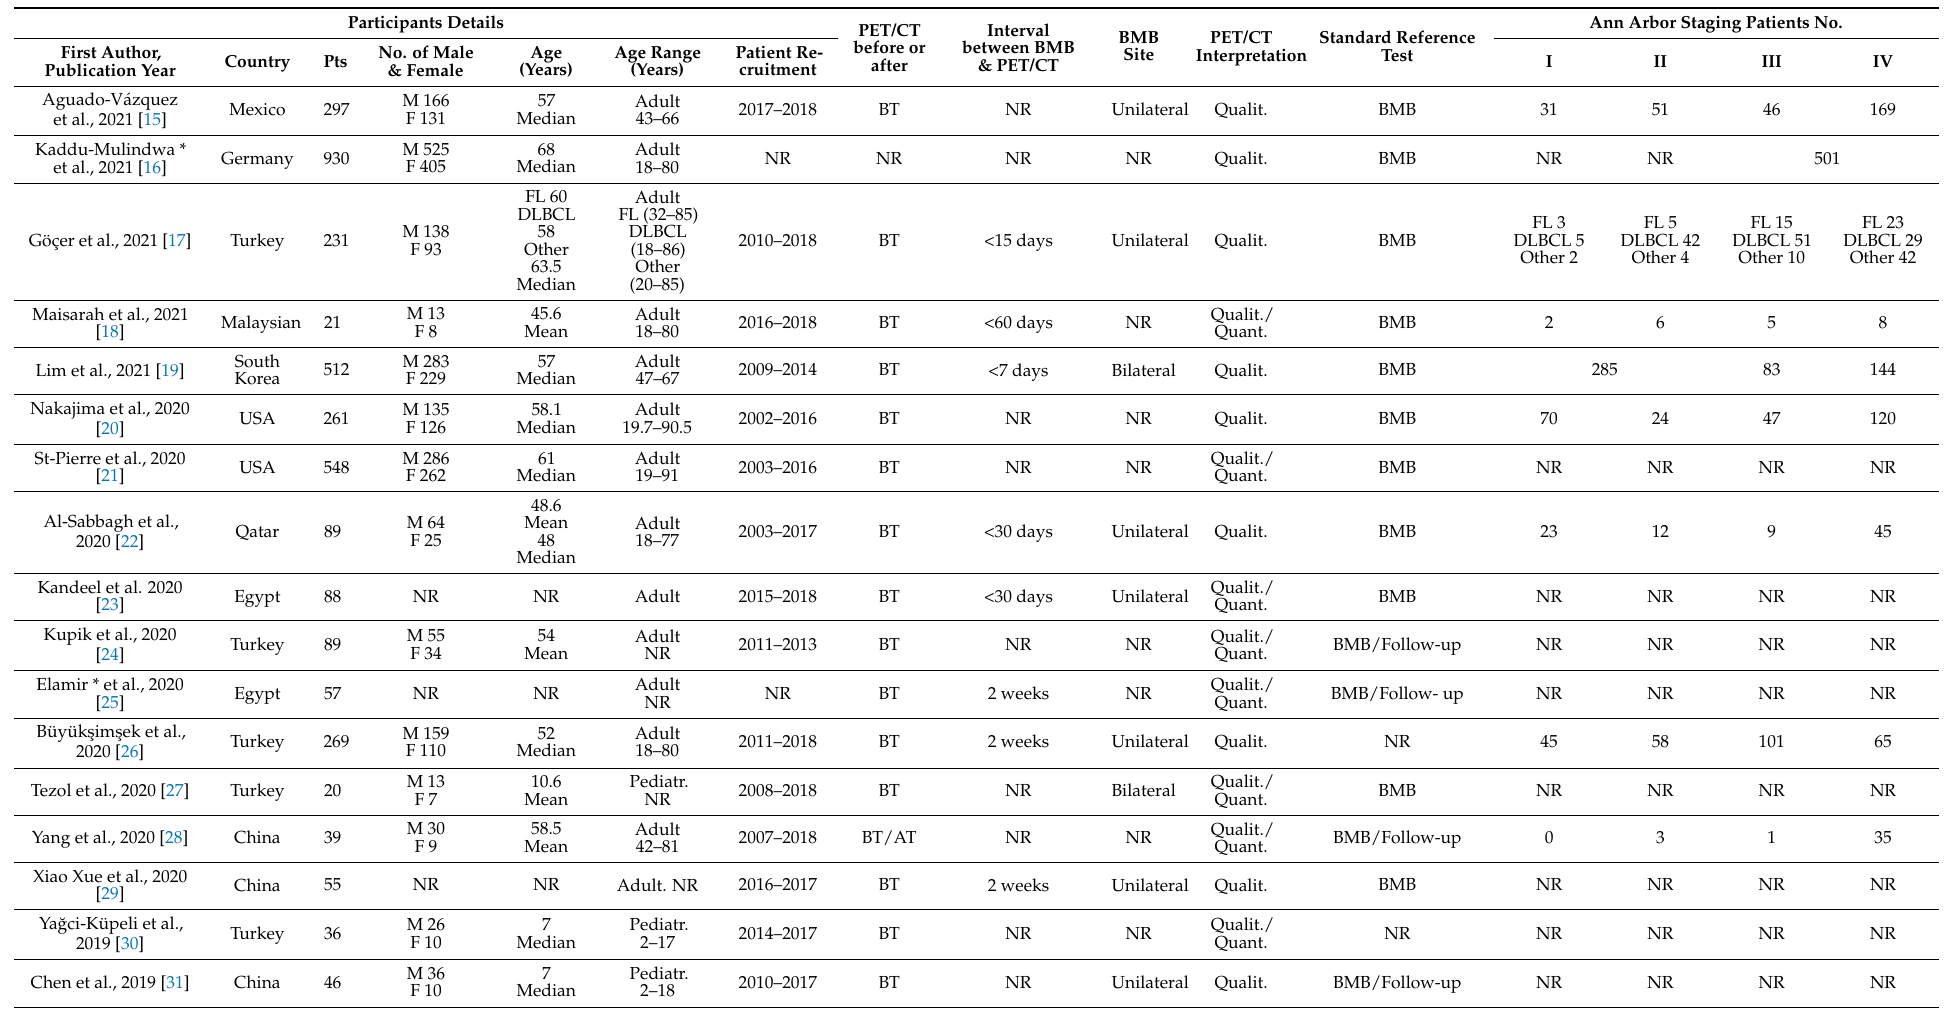
Table 2. Characteristics of the included